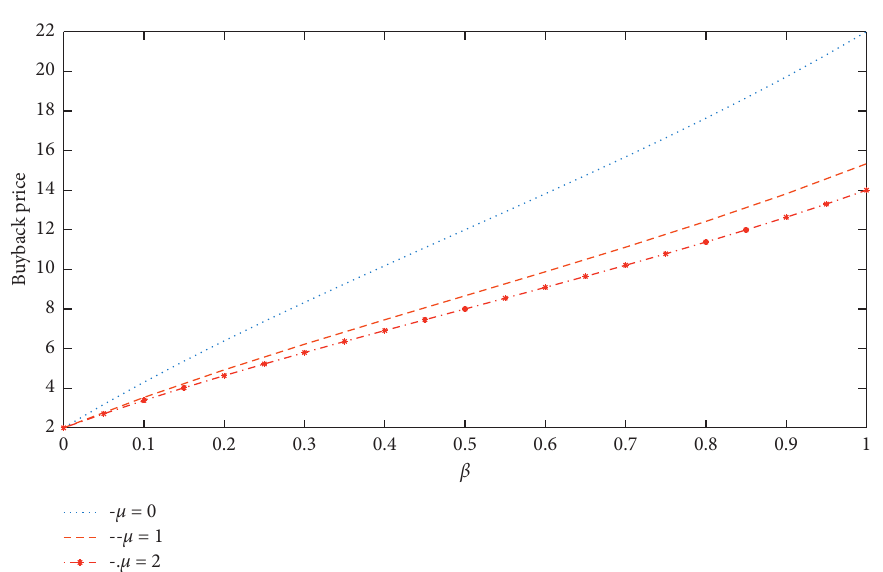
Figure 7: The effect of the cognitive biases on buyback price r ∗